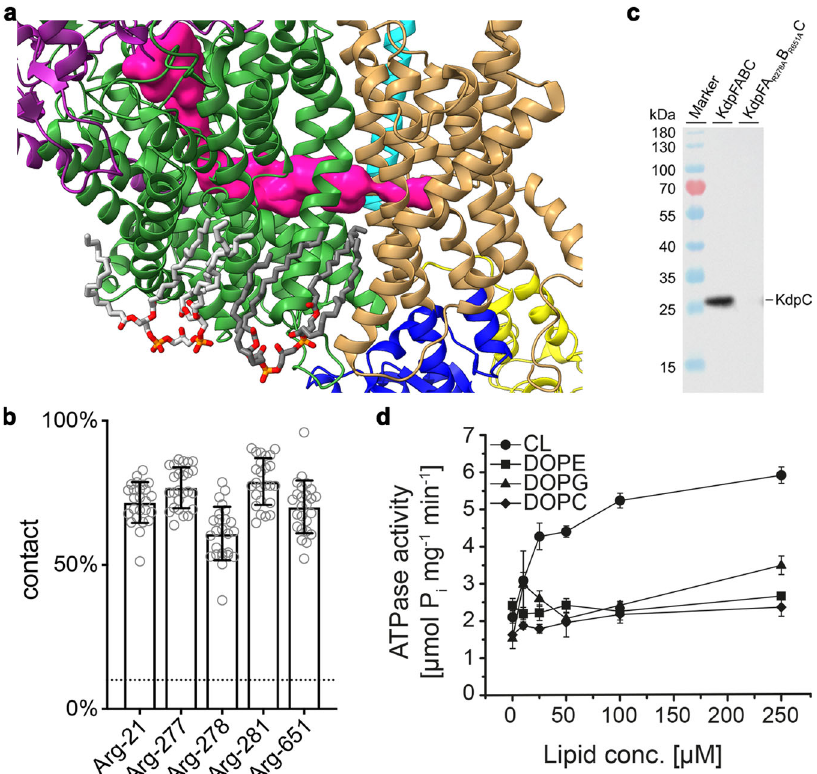
Fig. 2 Cardiolipin in KdpFABC. a Two identi fi ed cardiolipin (CL) molecules (gray) bound to KdpFABC. A hydrocarbon tail of CL1 (dark gray) extends into the complex at the KdpA/KdpB interface. b Pooled CL contact probabilities of selected residues, from fi ve representative structures in various E1 and E2 conformations (5MRW, 6HRA, 6HRB, 7BGY, and 7NNL), measured as proportion of frames in a coarse-grained MD simulation the CL and the respective